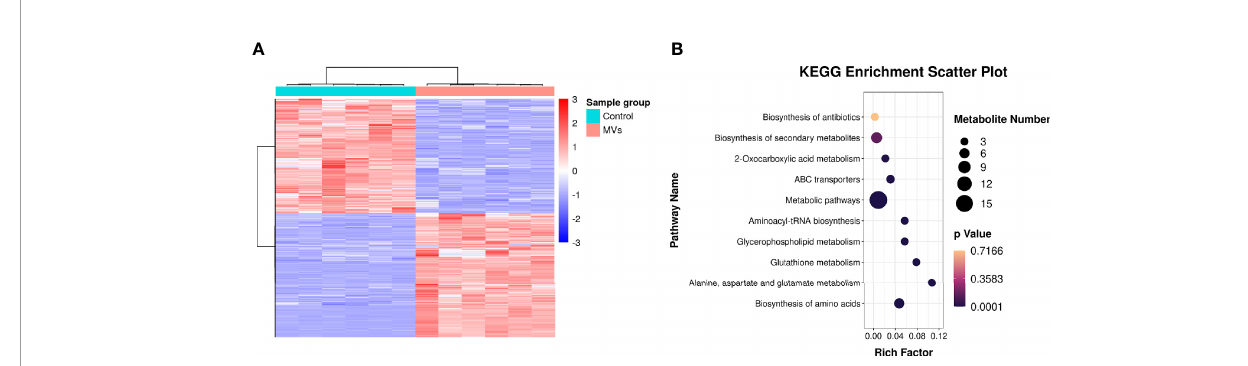
FIGURE 4 | Metabonomic analysis of C. albicans . (A) Hierarchical clustering of C. albicans metabonomics. (B) KEGG enrichment